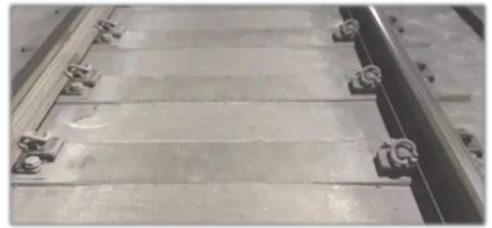
Figure 1. Ordinary monolithic track.